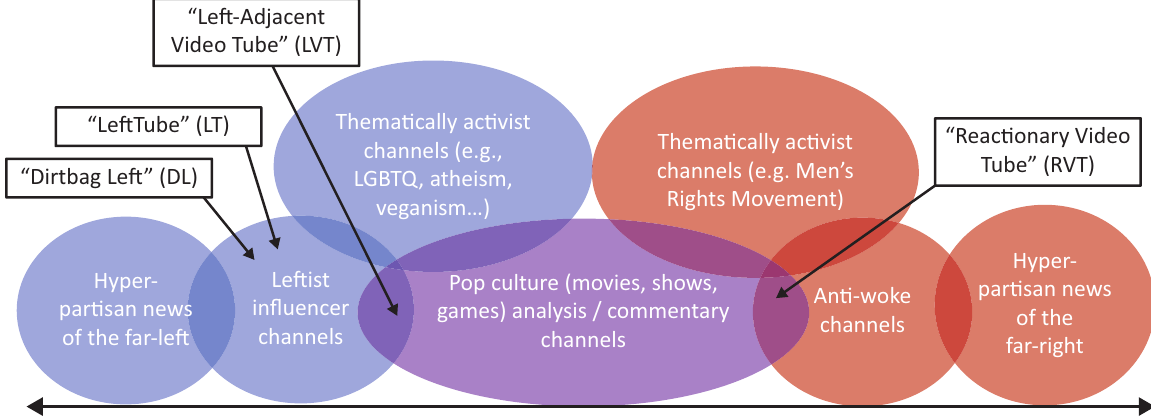
Figure 1. A selection of politically activist YouTube communities and their most common positions on the political spectrum.